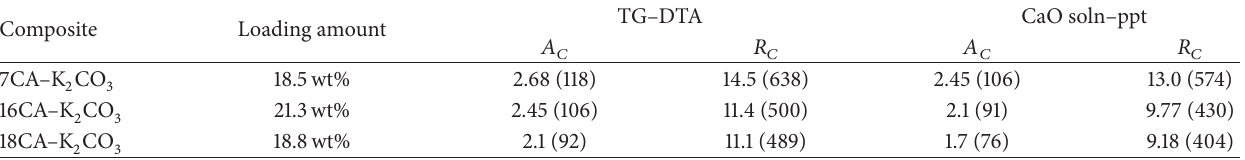
Table 2: CO 2 capture capacity, as measured by TG–DTA and CaO soln–ppt